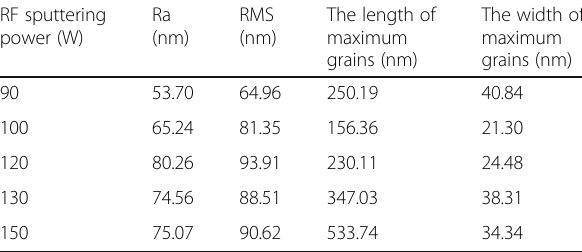
Table 1 The roughness and grain size of MnZn ferrite thin film deposited at different RF